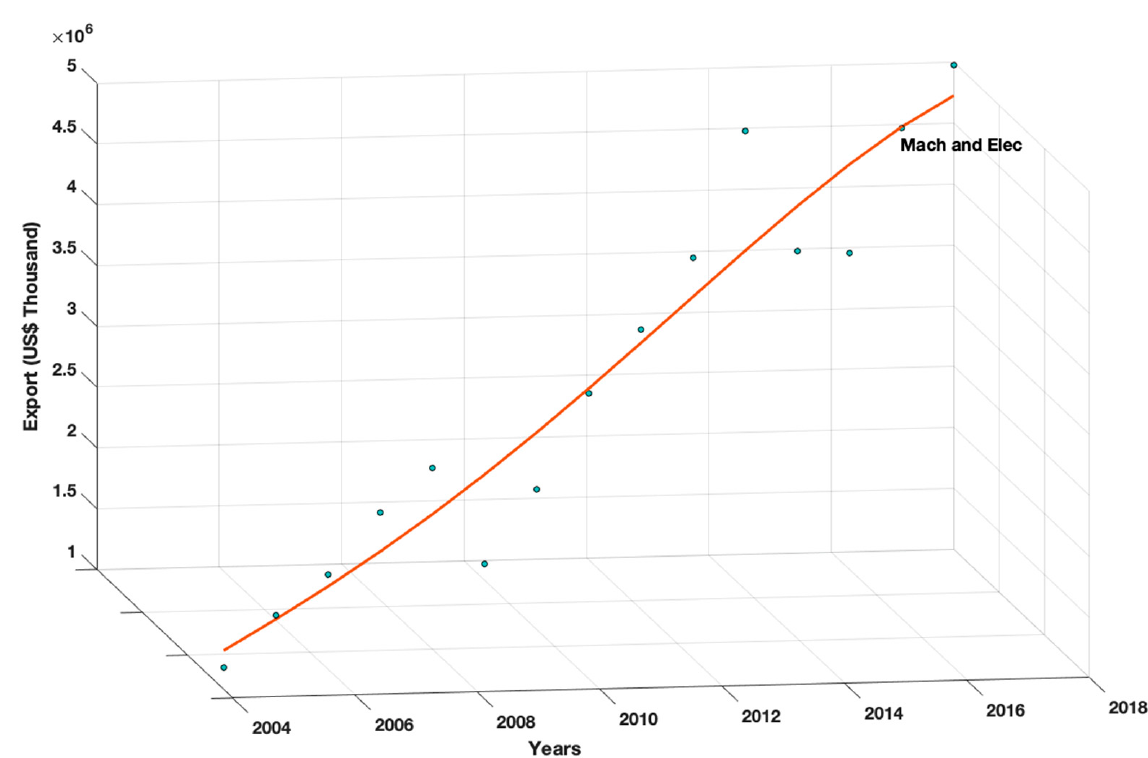
Figure 3. The degree 4